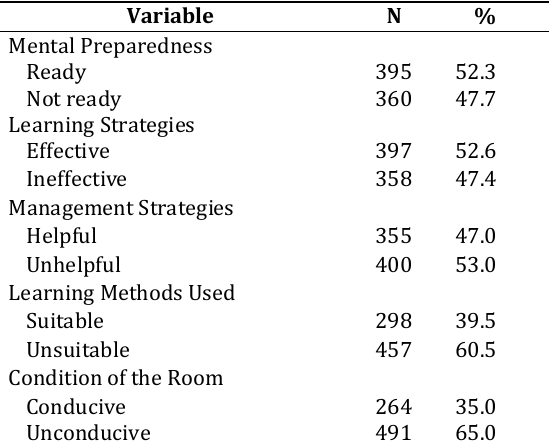
Table 2. The Distribution of the Levels of Mental Preparedness, Learning Strategies,